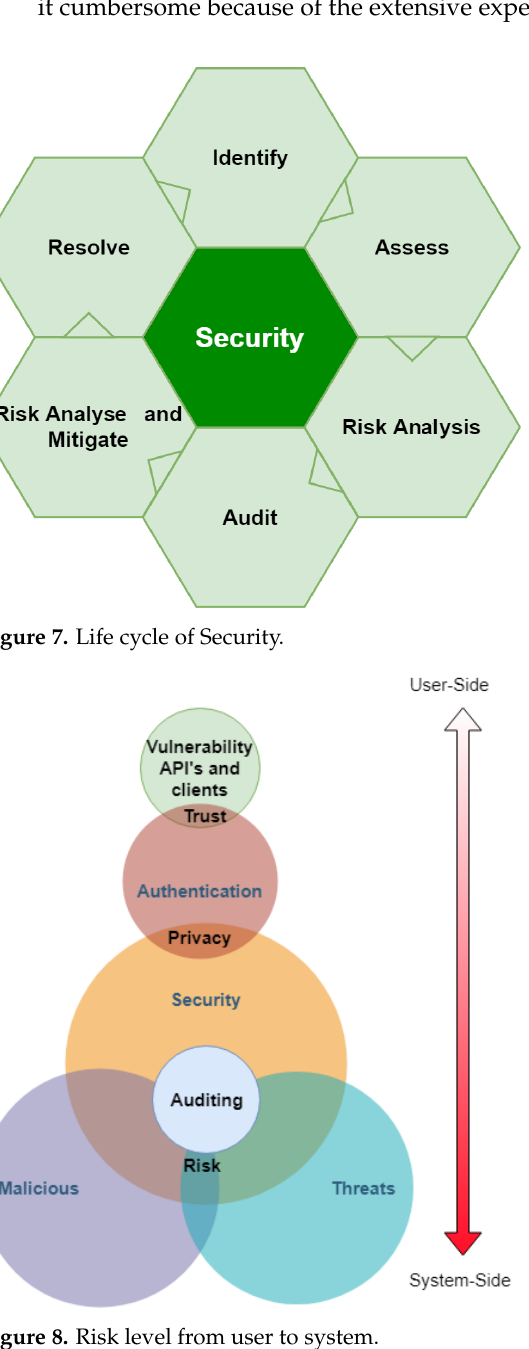
Figure 8. Risk level from user to